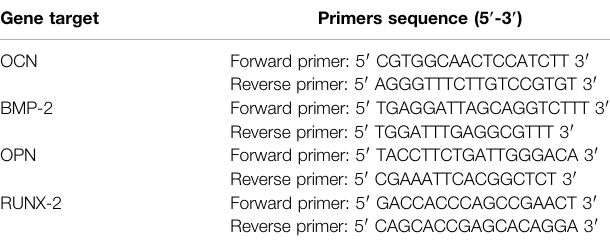
TABLE 2 | Primer sequences of osteogenic genes expressed by hBMSCs. Gene target Primers sequence (5 9 -3 9 )